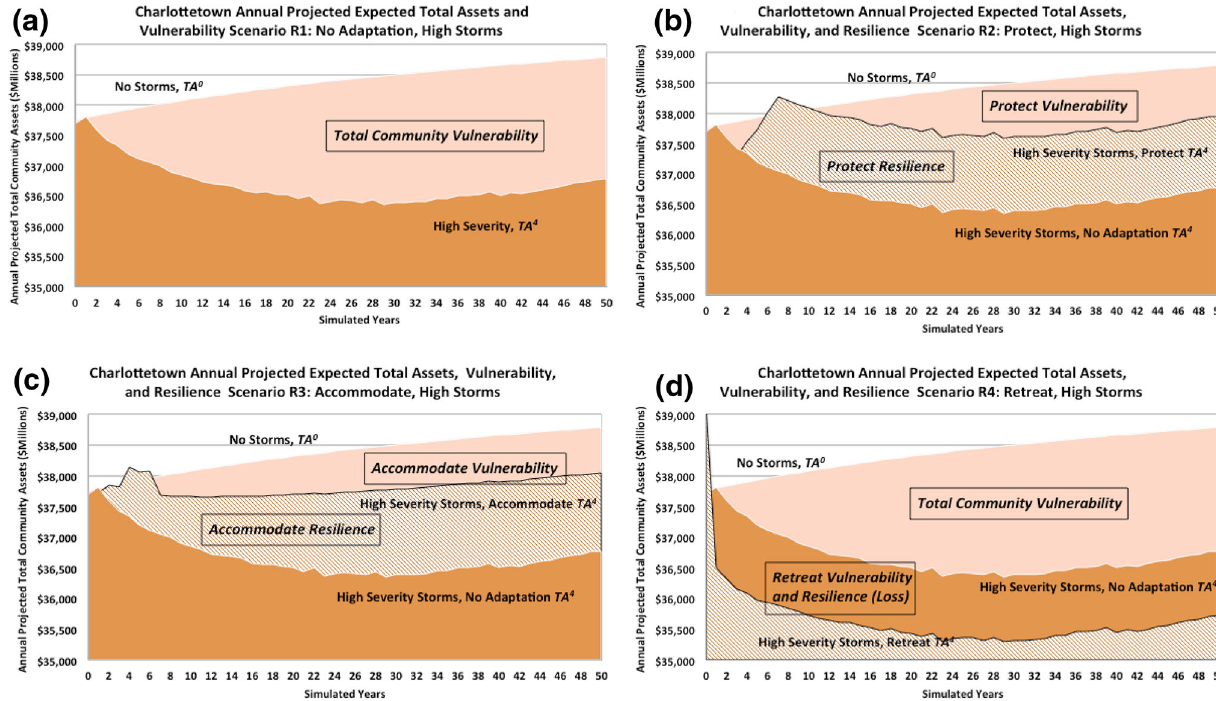
Fig. 5 Charlottetown, Prince Edward Island, simulation High Severity Storms scenario average results for Total Community Assets, Vulnerability, and Resilience over 10 trials assuming: a Scenario R1—no adaptation; b R2—protect; c R3—accommodate; and d